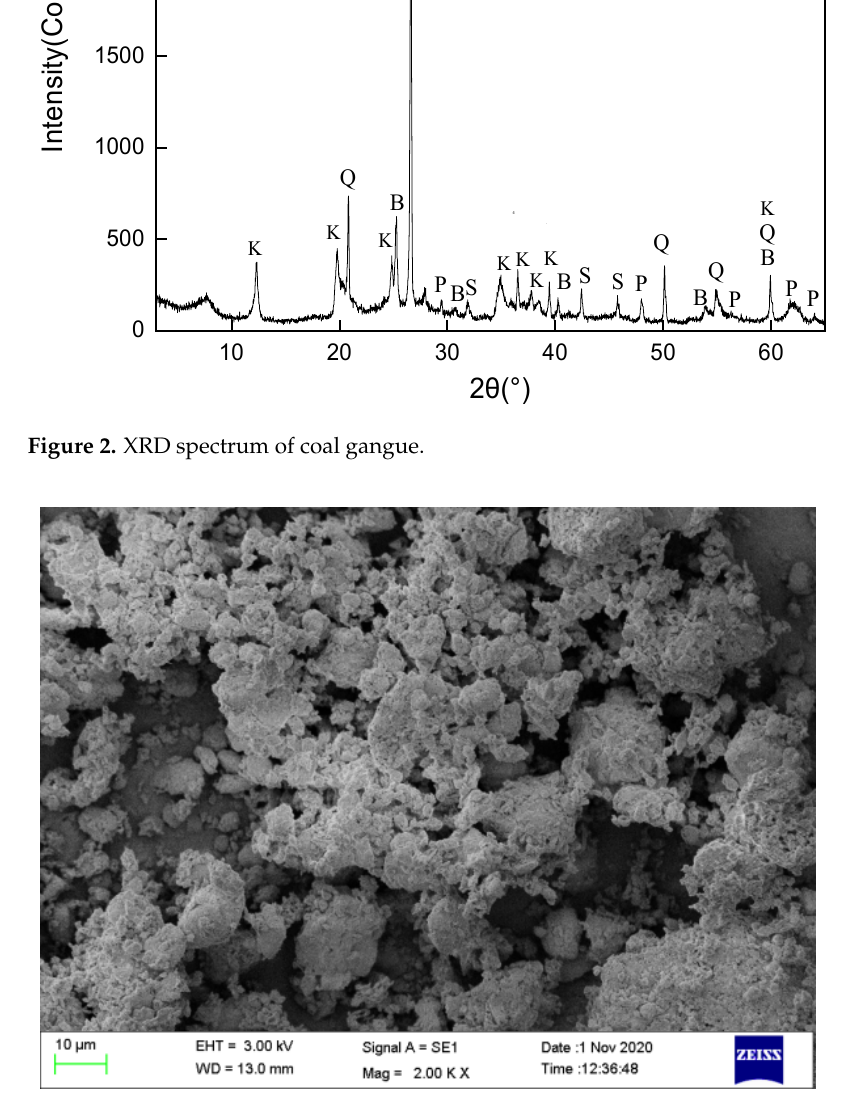
Figure 2. XRD spectrum of coal gangue.